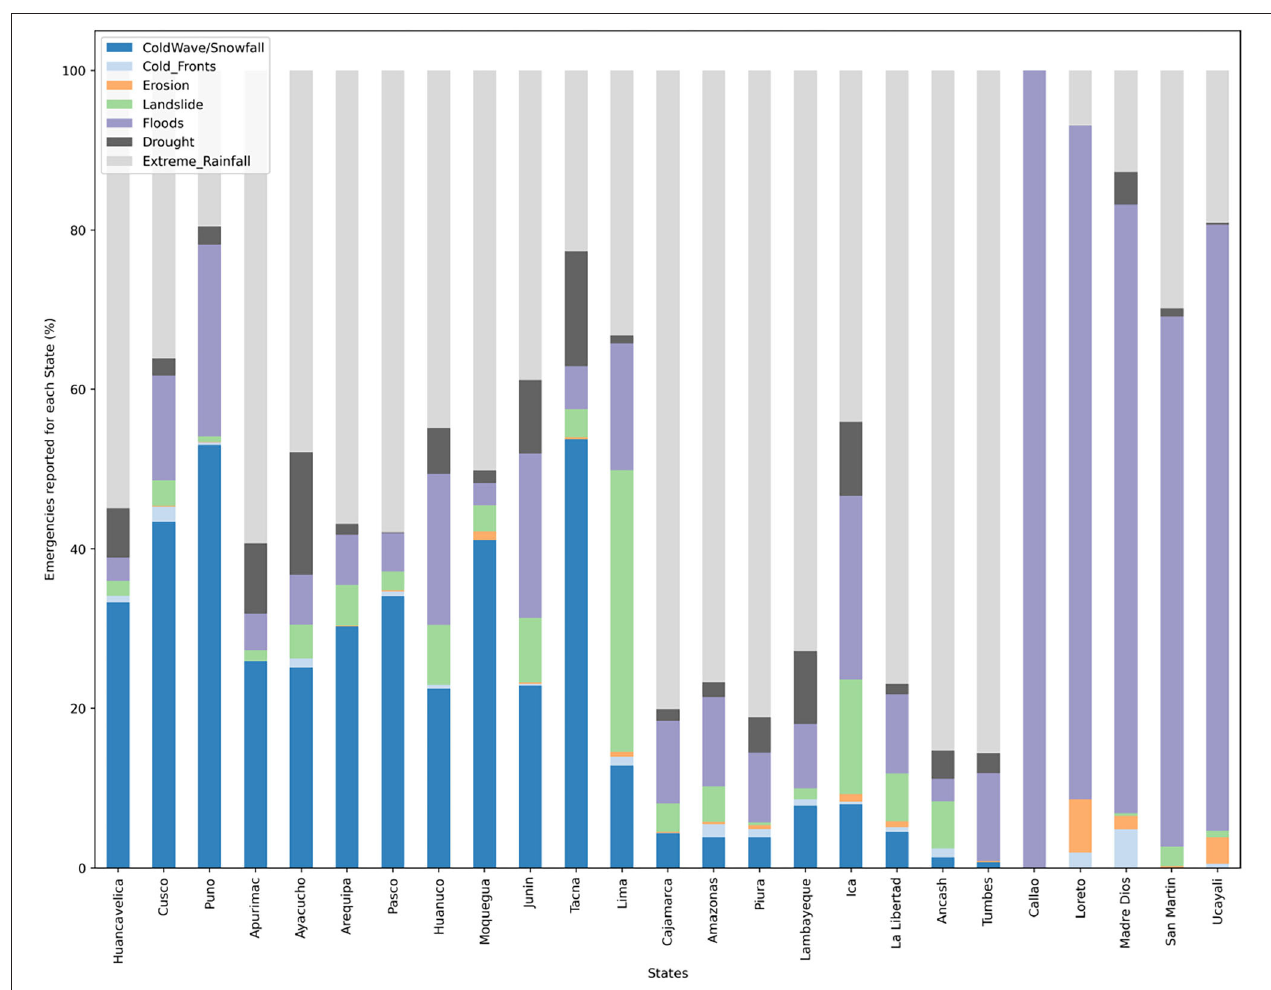
FIGURE 1 | National emergencies reported by the civil defense from